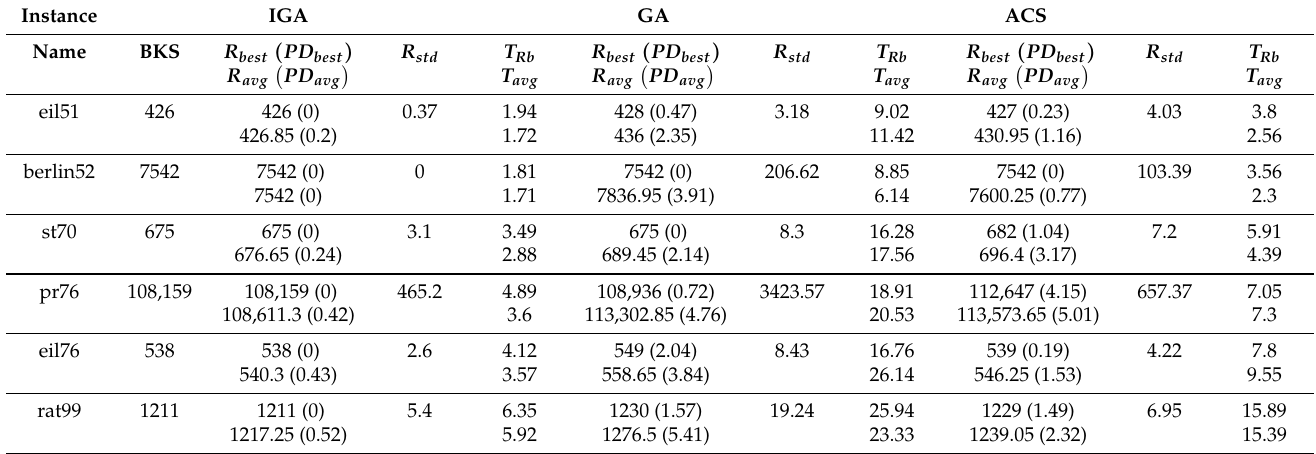
Table 2. Results obtained by IGA, GA, and ACS on 42 small-scale